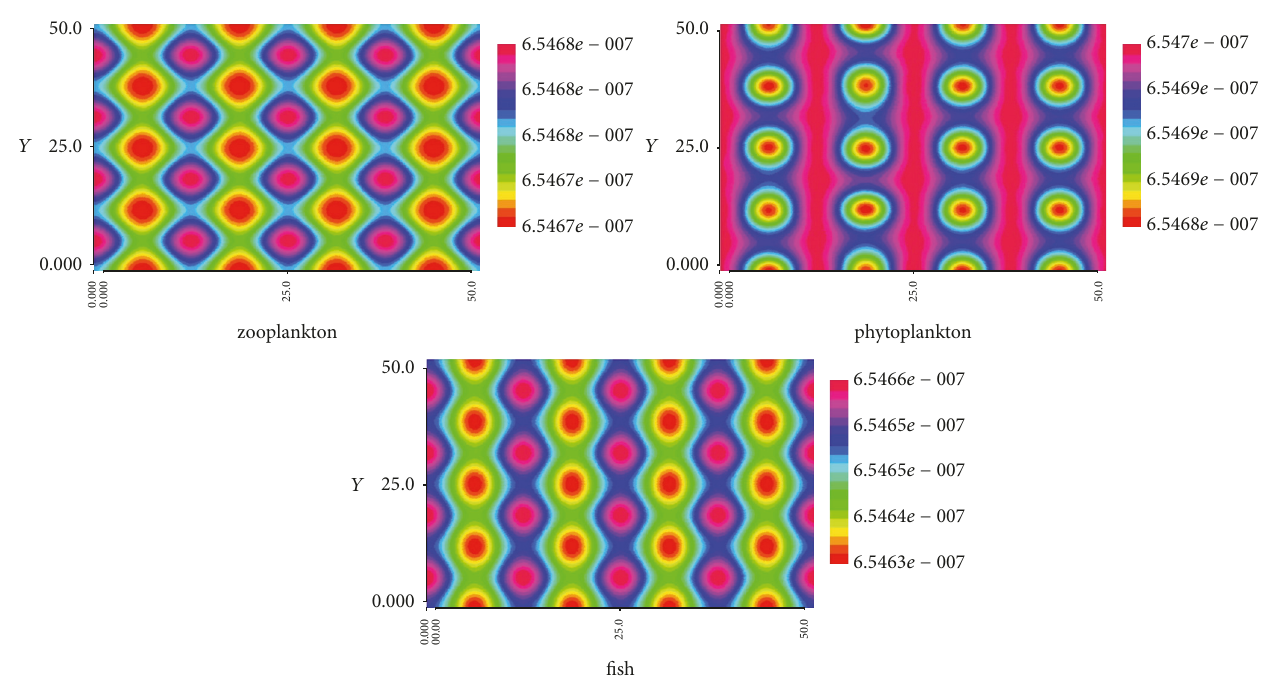
Figure 3: Spatial distribution of the system with 𝑏 0 = 0.38 and 𝛼 0 = 0.54